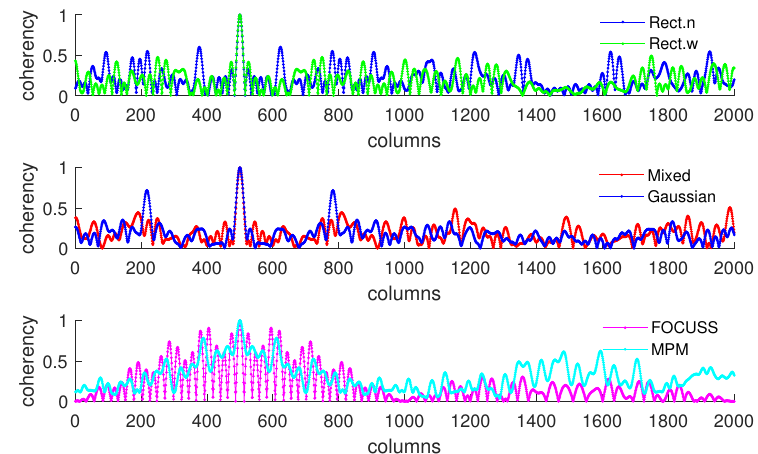
Figure 10. Coherence curves in each subarray generated in Simulation 2 at direction θ = π